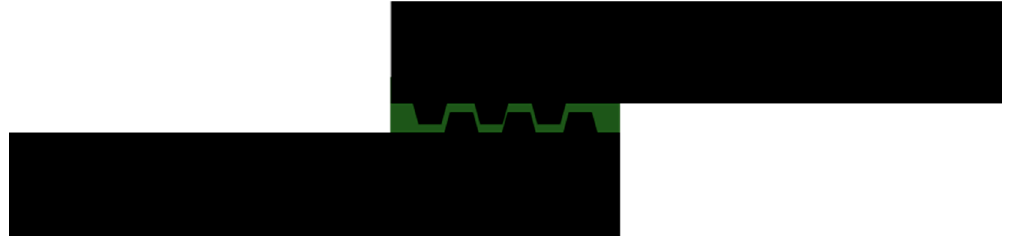
Figure 12. Adherends with a AM deposed pattern at the overlap in the bondline volume [54].